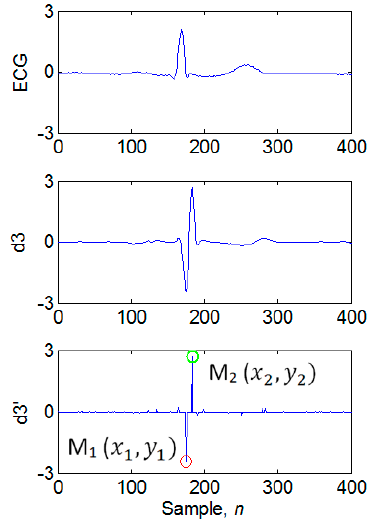
Figure 7. Illustration of an extremum pair in d3’.